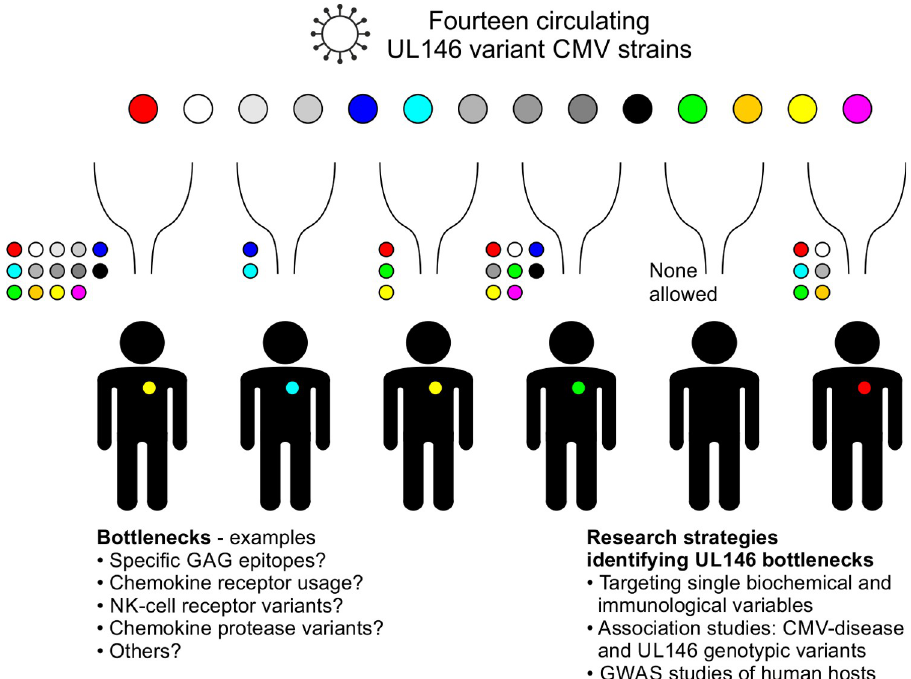
Fig 11. Hypothetical model explaining the existence of 14 stable UL146 genotypes by bottlenecks in the genetic makeup of the host. Unidentified bottlenecks in the host allowing only one or some of several possible UL146 genotypes among circulating HCMV strains to establish infection and disseminate in a given host. Small circles show which UL146 strains are able to pass the bottleneck. Note that i) different bottlenecks can allow infection from between one and 14 genotypes, and ii) a given host/HCMV strain pair can be the result of different bottlenecks (yellow virus on human that could potentially be infected by multiple different strains). Bottom left: examples of human proteins representing potential bottlenecks. Bottom right: examples of possible research strategies for identifying host